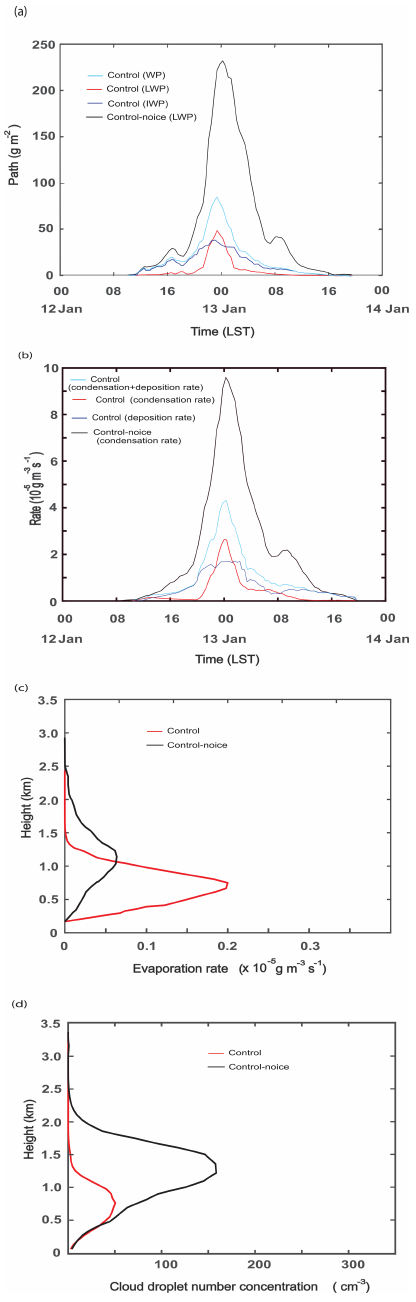
Figure 5. Time series of (a) the domain-averaged liquid-water path (LWP), ice-water path (IWP), and water path (WP), which is the sum of LWP and IWP, for the control run and LWP for the control- noice run and (b) the domain-averaged condensation rates, deposi- tion rates, and sum of those rates in the control run and condensation rates in the control-noice run. (c) Vertical distribution of the time- and domain-averaged evaporation rates and (d) the average CDNC over grid points and time steps with non-zero CDNC for the initial stage between 00:00 and 20:00LST on 12